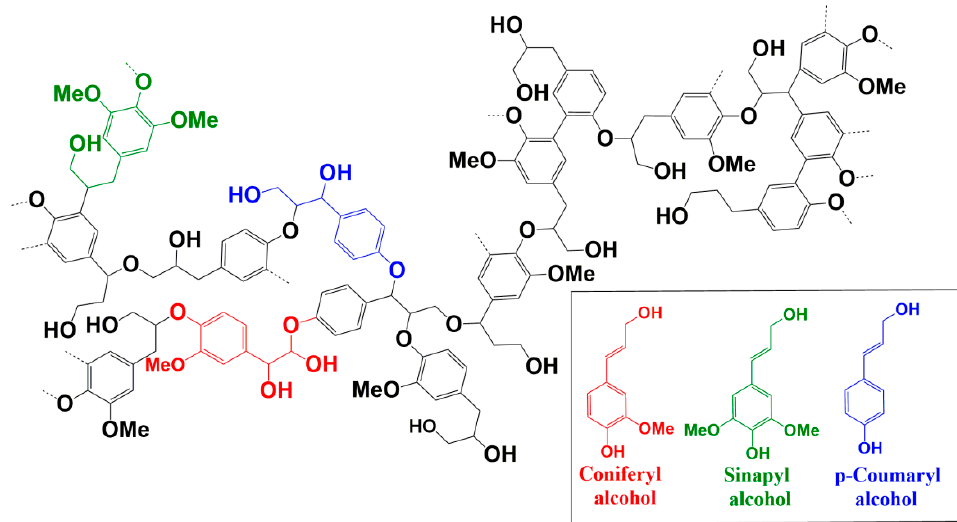
Figure 1. The proposed structure of lignin. Inset: three primary units of lignin.